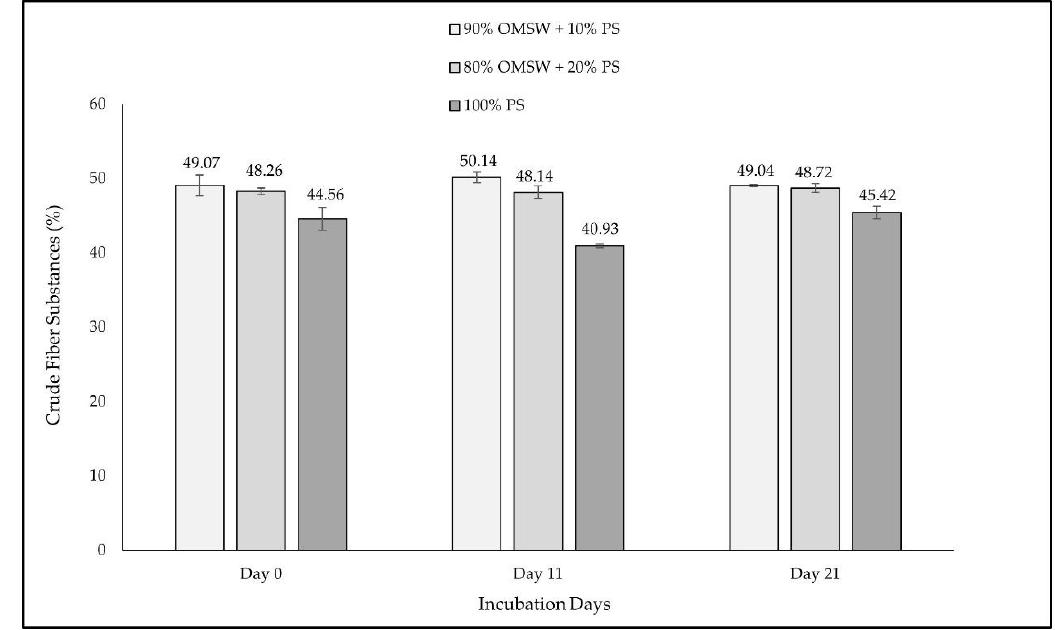
Figure 4. Assessment of Crude Fiber Substances content for PS and its mixtures with OMSW. Sta- tistical analysis was performed for each substrate individually between Day 0 and Day 21.